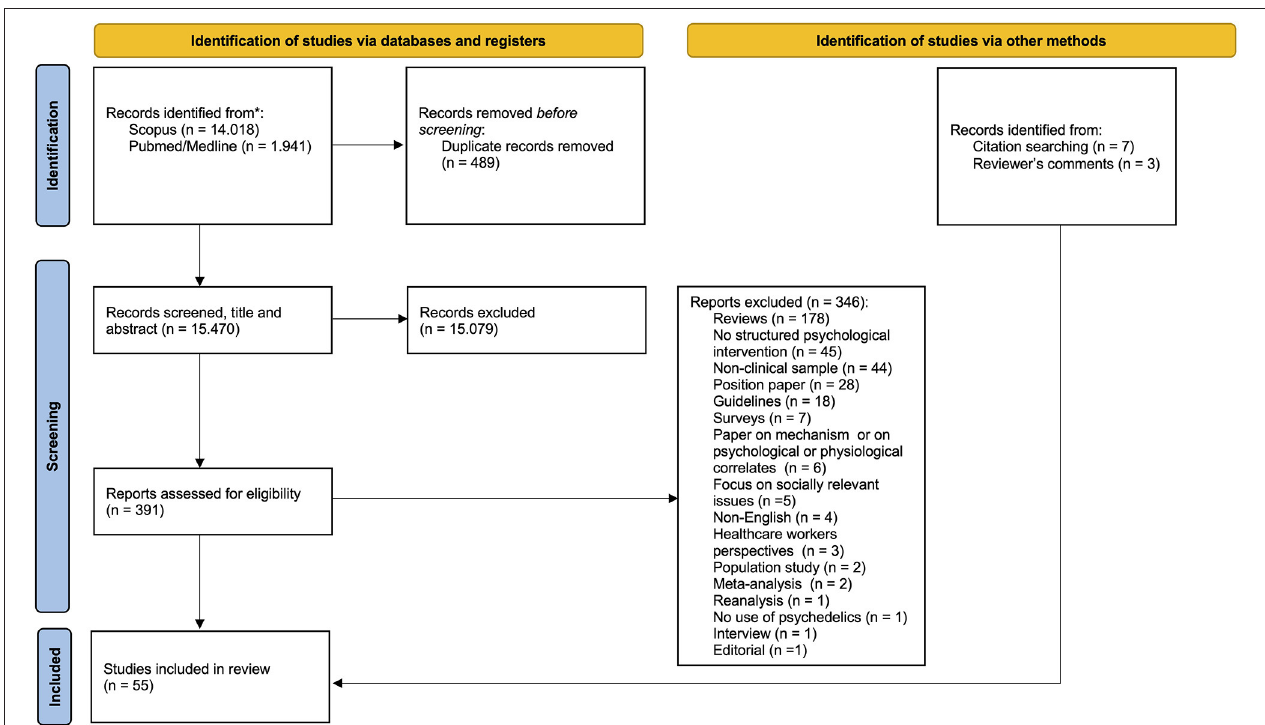
FIGURE 1 | PRISMA